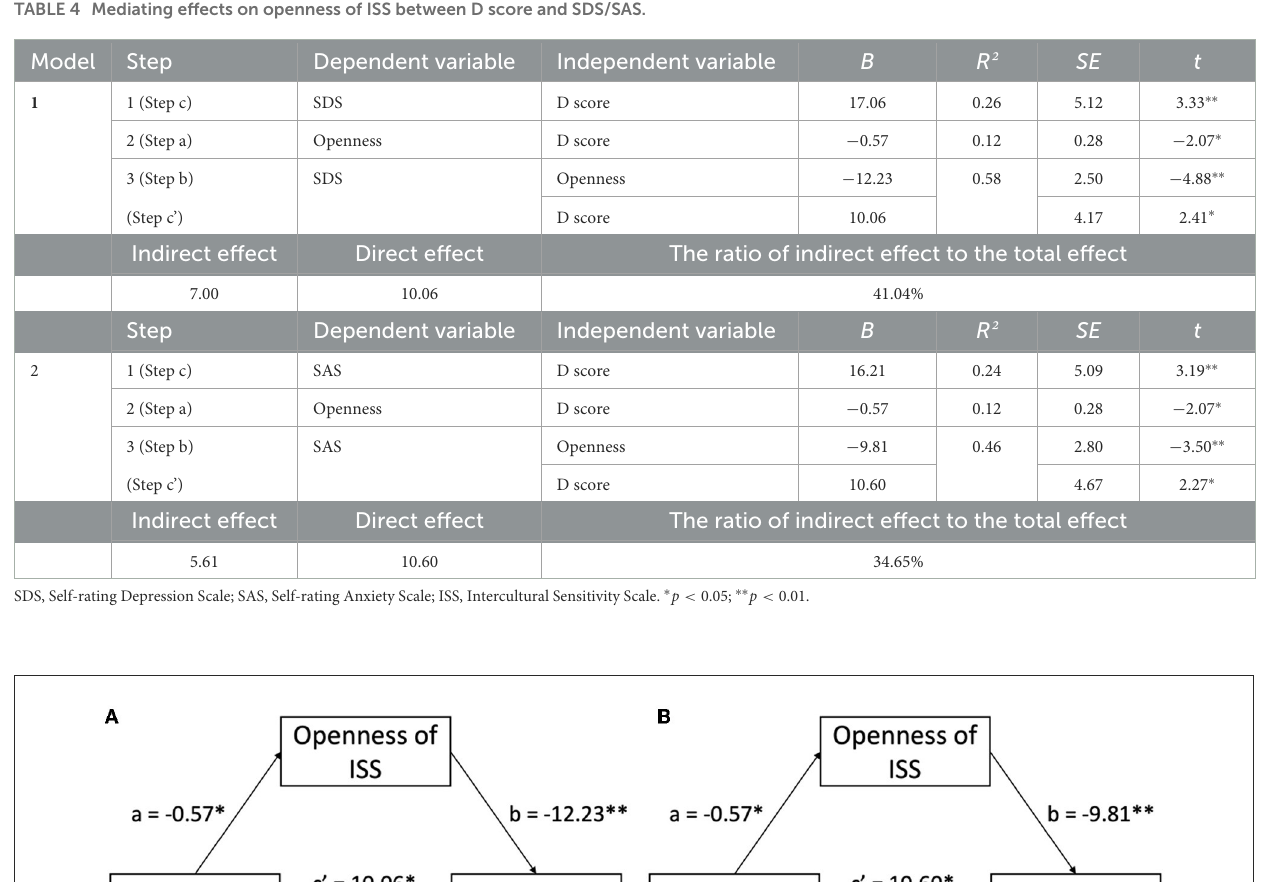
TABLE 4 Mediating effects on openness of ISS between D score and SDS/SAS.